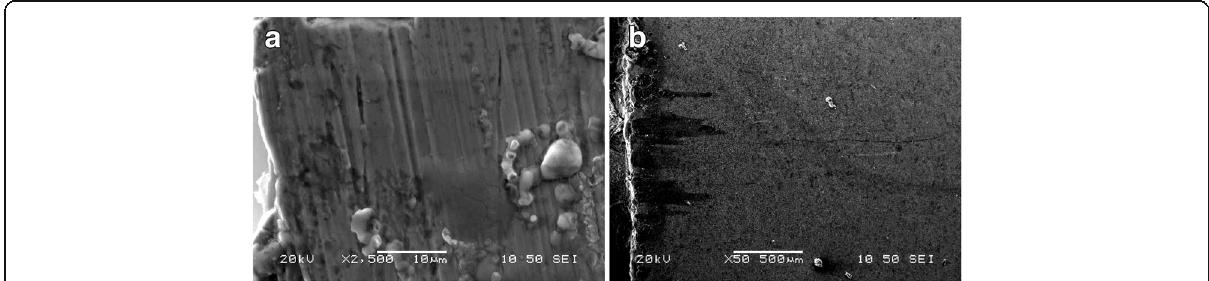
Fig. 4 SEM micrographs of SAE 5130 steel, adjacent to cutting zone, showing a the apparition of micro-cracks and b deep crack that reach the bulk